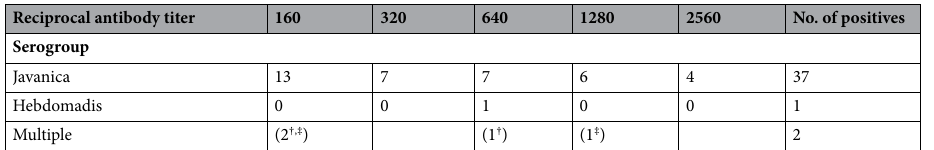
Table 1. Frequency of anti- Leptospira antibodies in cats. † The cat FS13001 exhibited the reciprocal MAT titer 160 and 640 for serogroups Ballum and Javanica, respectively. ‡ The cat FS18013 exhibited the reciprocal MAT titer 160 and 1280 for serogroups Autumnalis and Hebdomadis, respectively. MAT, microscopic agglutination test.